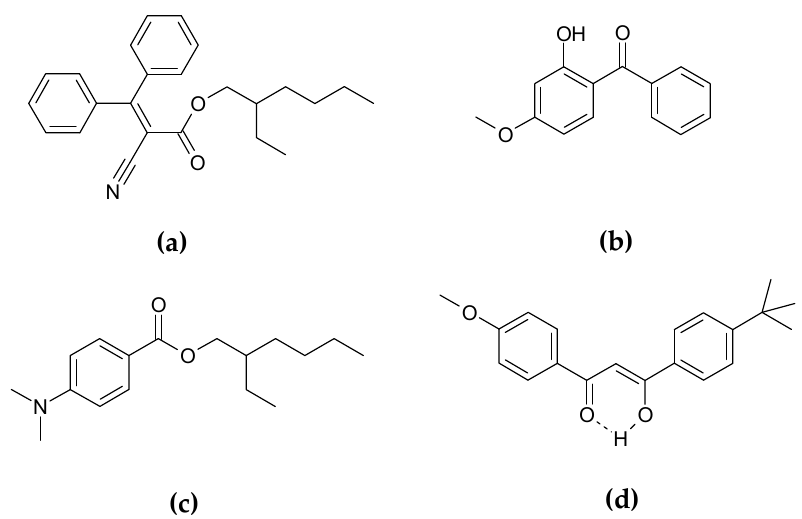
Figure 11. Figure 11. Chemical structure of immobilized chemical UV filter as GSPN: ( a ) octocrylene; (b ) benzophenone-3 (BP-3); ( c ) 2-ethylhexyl-p-dimethylaminobenzoate (EHMAB); ( d ) avobenzone.